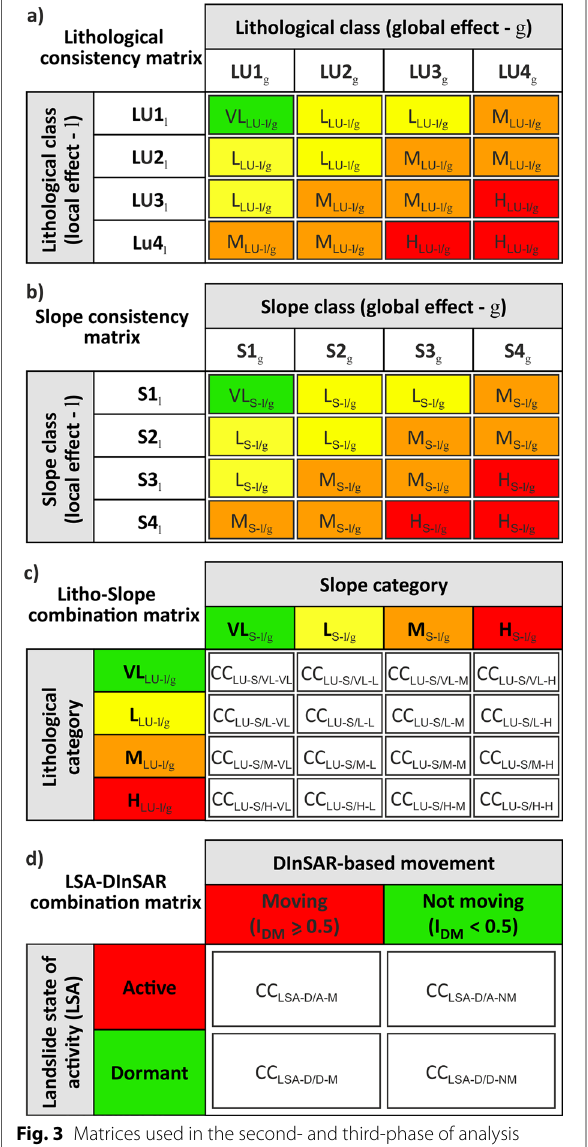
displacements on the VA are induced by the SML movements.